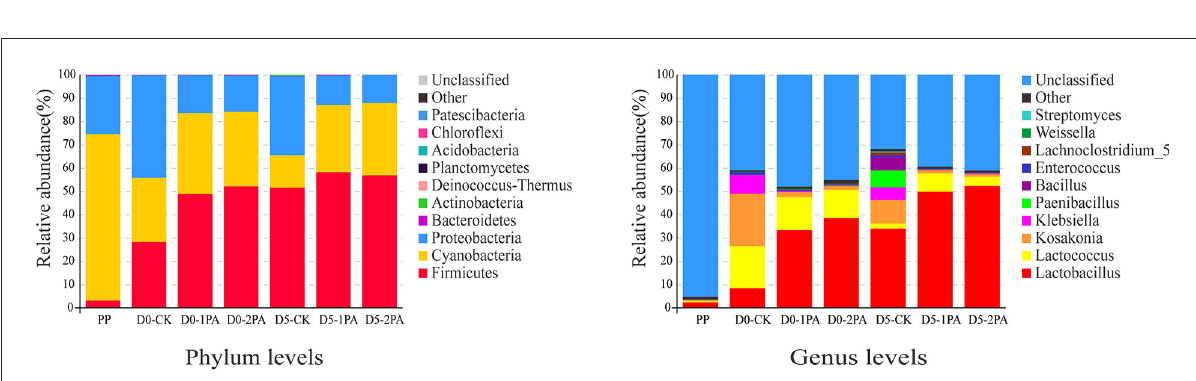
FIGURE4 Relative abundance of bacterial communities for Napier grass silages treated without or with 1 and 2% pyroligneous acid after 30 days of ensiling and 5 days of exposure to air. PP, fresh